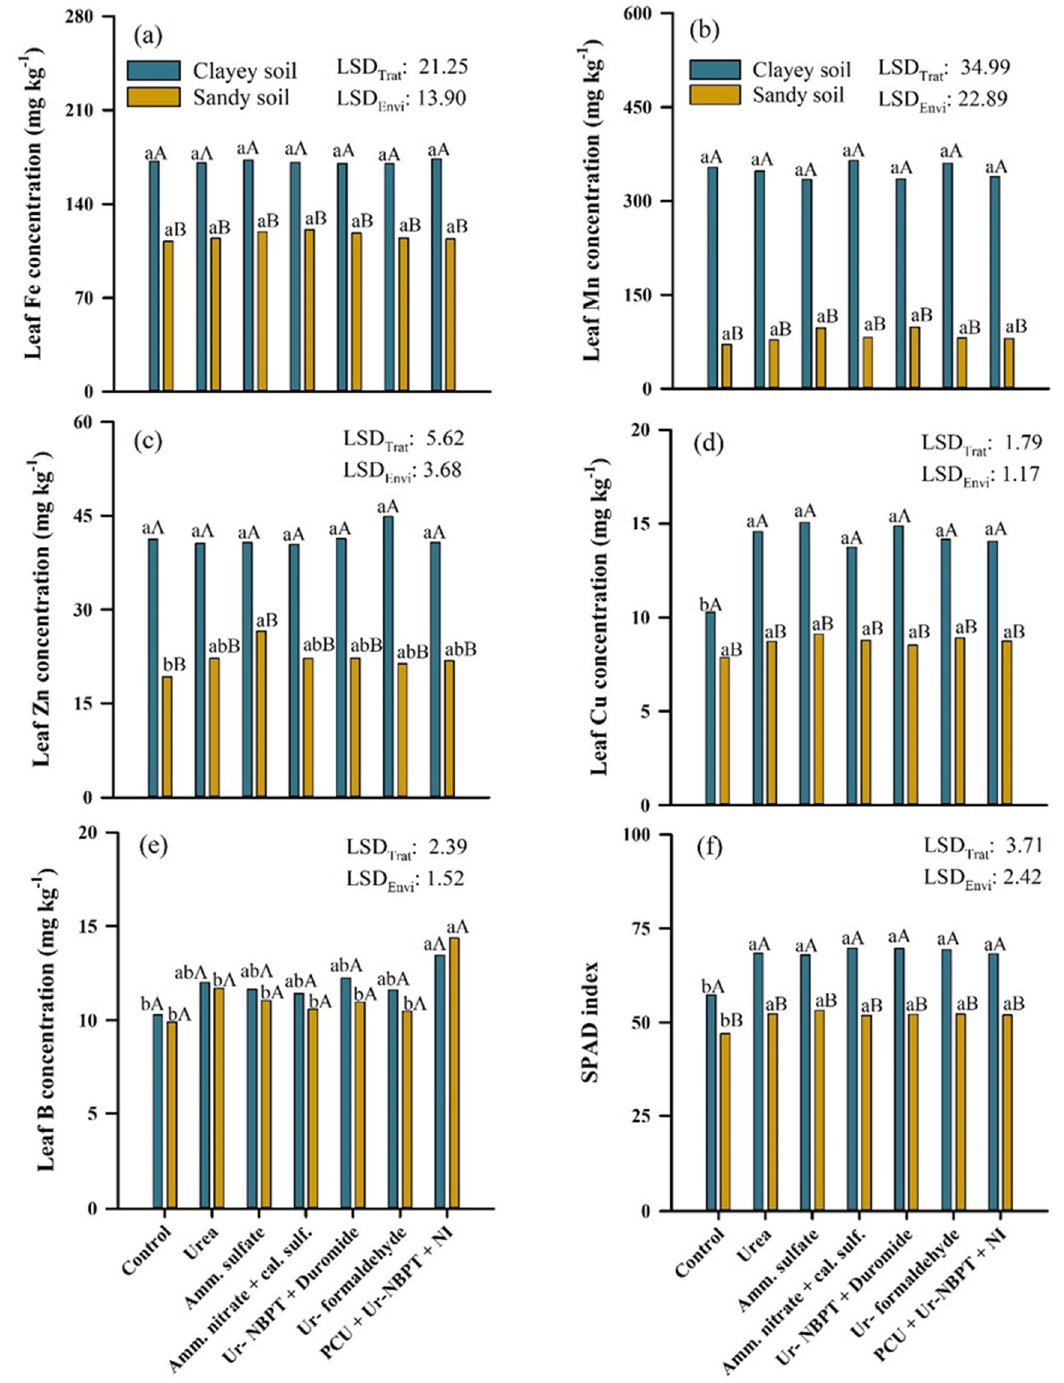
Figure 7. Concentration of iron ( a ), copper ( b ), zinc ( c ), manganese ( d ), boron ( e ), and SPAD index ( f ) in the corn leaf after fertilization in topdressing with nitrogen sources urea, ammonium sulfate, ammonium nitrate + calcium sulfate, Ur-NBPT + Duromide, Ur-formaldehyde, and PCU + Ur-NBPT + NI for clayey and sand soil. Treatments followed by the same lowercase letter do not differ using a Tukey test ( p < 0.05). Environments followed by the same capital letter do not differ using a Tukey test ( p < 0.05). LSD Trat : least significant difference for treatments. LSD Envi : least significant difference for environment. Leaf Cu levels increased with topdressing N fertilization only in relation to the con- trol, with an average increase of 4.13 (40.1%) mg kg − 1 for clayey soil; but in sandy soil, there was no difference between treatments. Similarly to Fe, Mn, and Zn, the levels of leaf